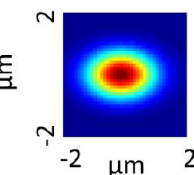
Figure 7. Point spread function (PSF) approximated by fitting Gaussian functions to the derivatives of line maps from measurements across the edge of an Au structure in a 1951 USAF patterned Au/Si reference sample.